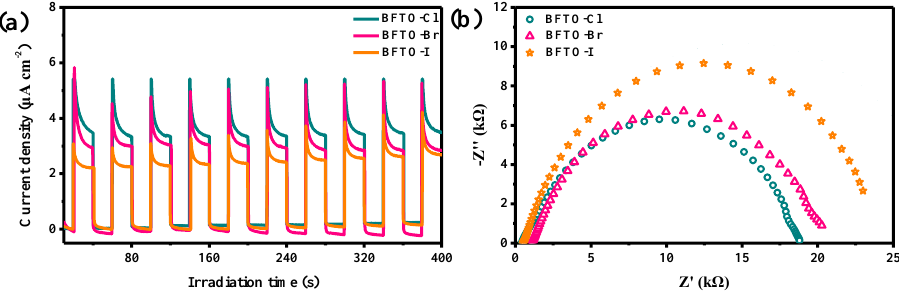
Figure 6. ( a ) Transient photocurrent densities and ( b ) EIS Nyquist plots of BFTOX (X = Cl, Br, and I).